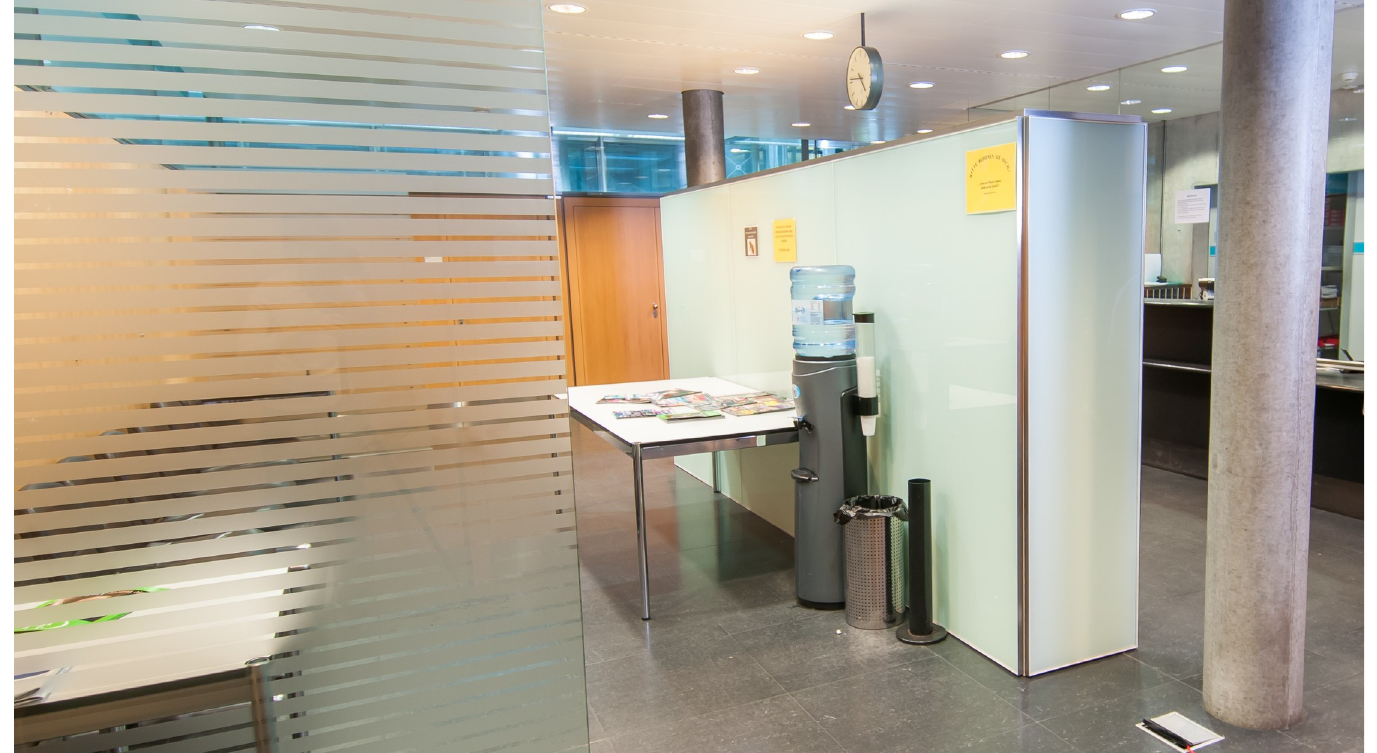
Fig 1. Control group waiting area without an